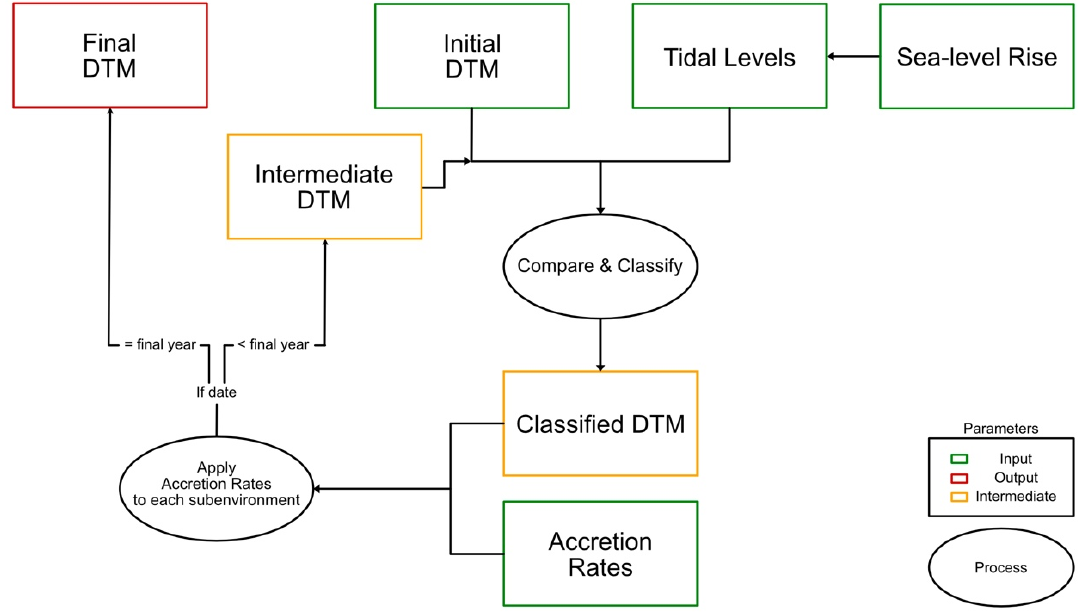
Figure 2. Flowchart showing relations among the parameters of SMRM, including inputs, outputs, intermediate parameters and processes.